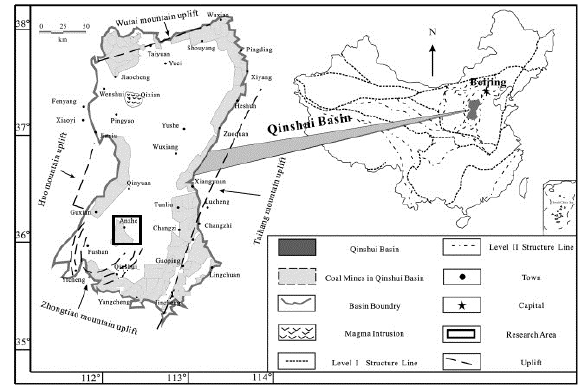
Figure 1. Illustration of the study area where coal samples were retrieved. Reprint with permission [24]; 2011, Elsevier Ltd.